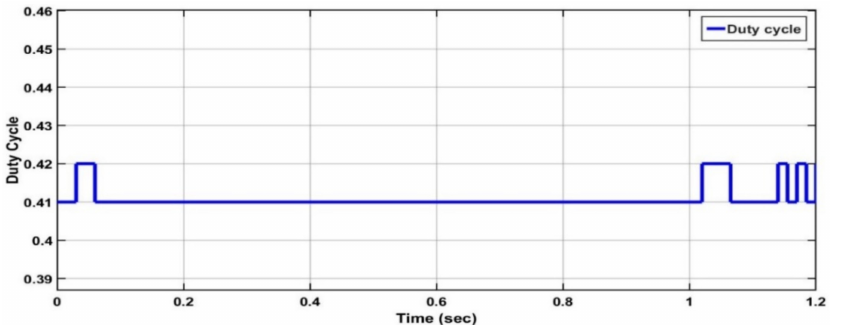
Figure 29. Duty cycle of Firefly Algorithm (Case-2).